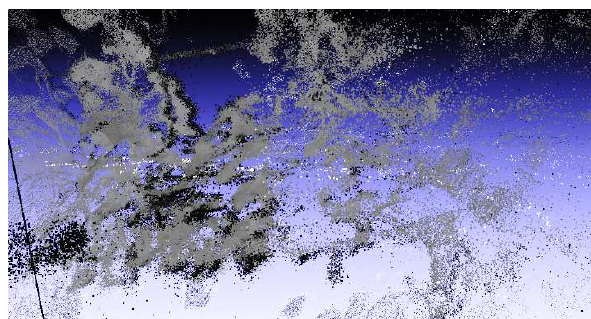
Figure 2: Visualized 3D point cloud of the grape canopy at the early stage of grape ripening.